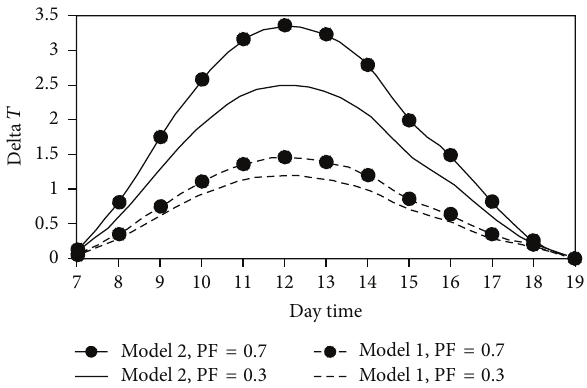
Figure 7: Air temperature increase in Models 1 and 2.